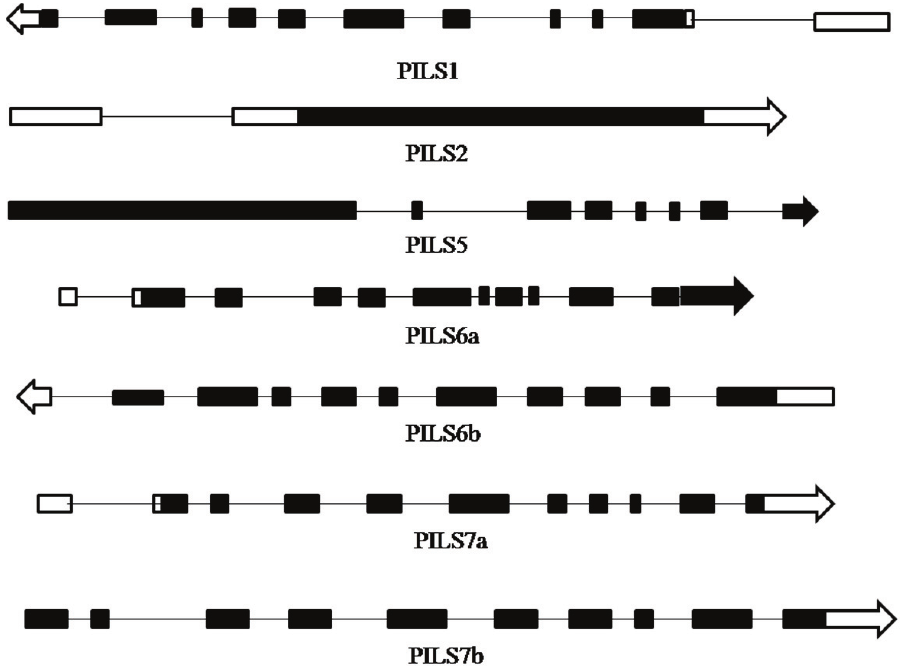
Figure 1. Genomic organization of different OsPILS genes. The black colored boxes represent the exons and lines represent the introns of different OsPILS genes. In the majority of cases, the majority of OsPILS genes contain 10 exons.